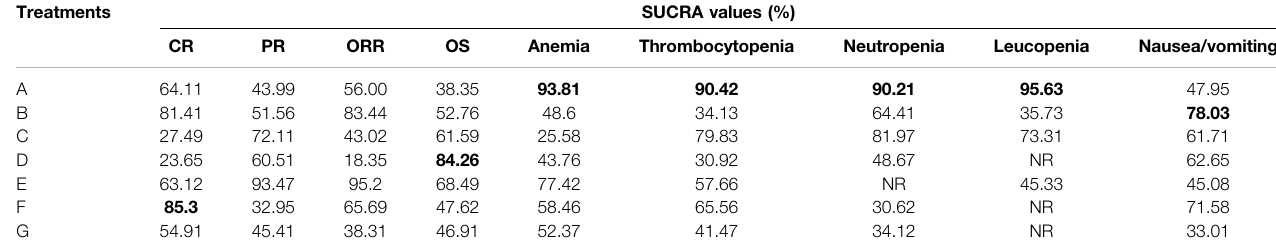
TABLE 4 | SUCRA values of seven chemotherapy regimens under nine outcomes. Treatments